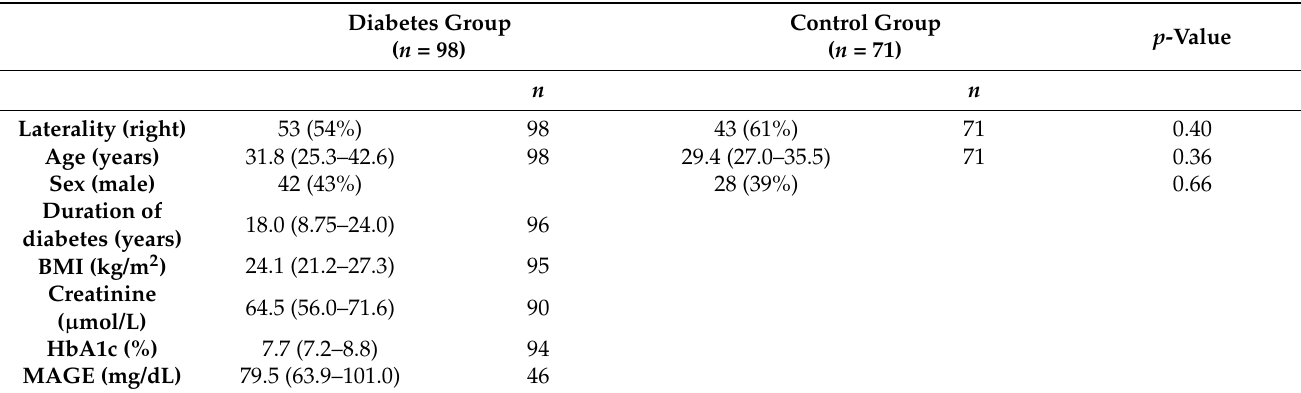
Table 1. Characteristics of the study